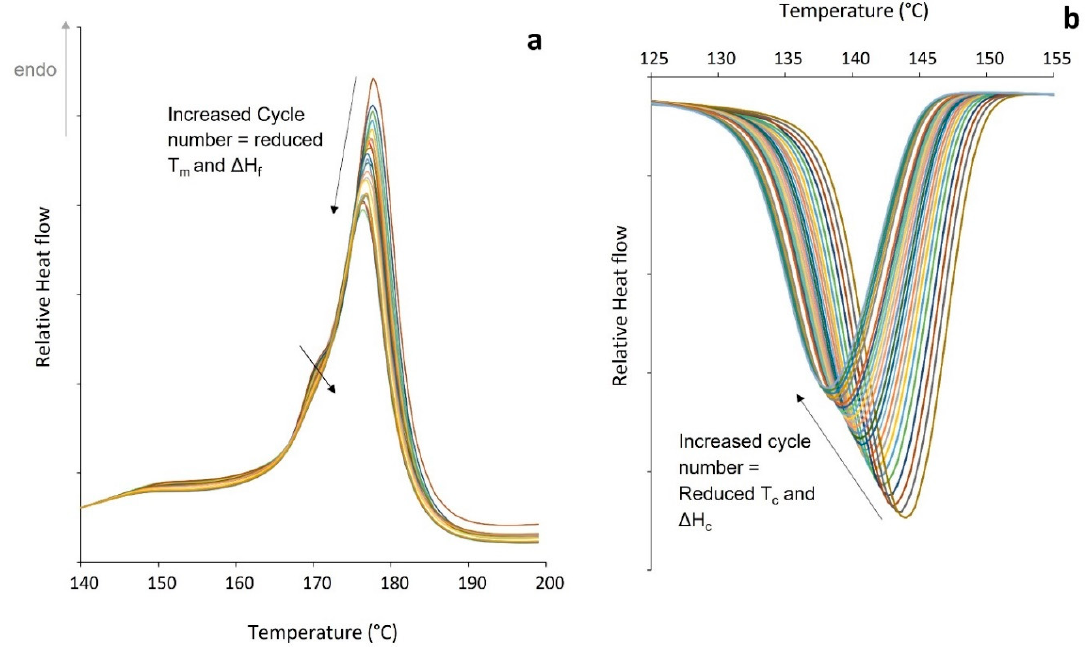
Figure 2. Change in ( a ) melting behaviour on heating and ( b ) crystallisation behaviour on cooling with repeated thermal cycling, to an upper temperature limit of 215 °C.